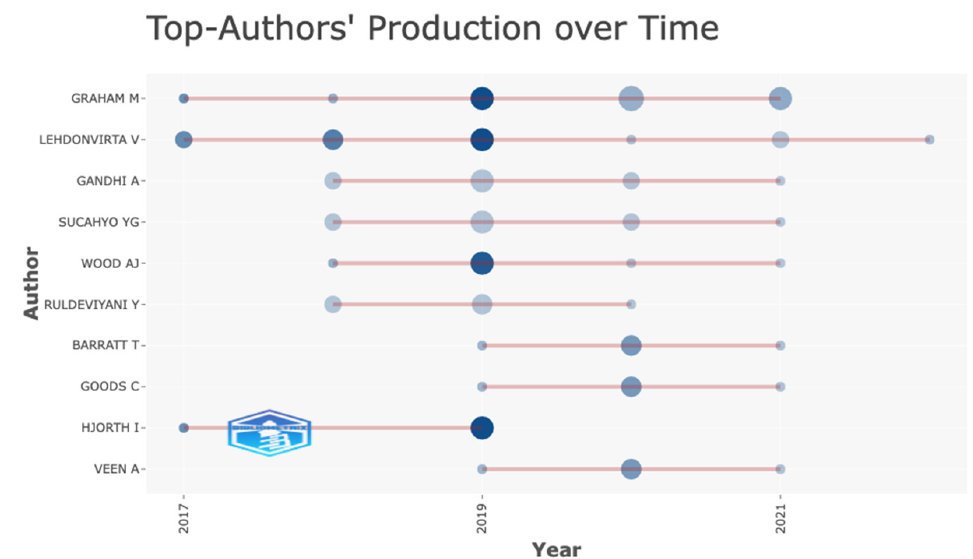
Figure 4. The authors’ productiveness. Source: RStudio